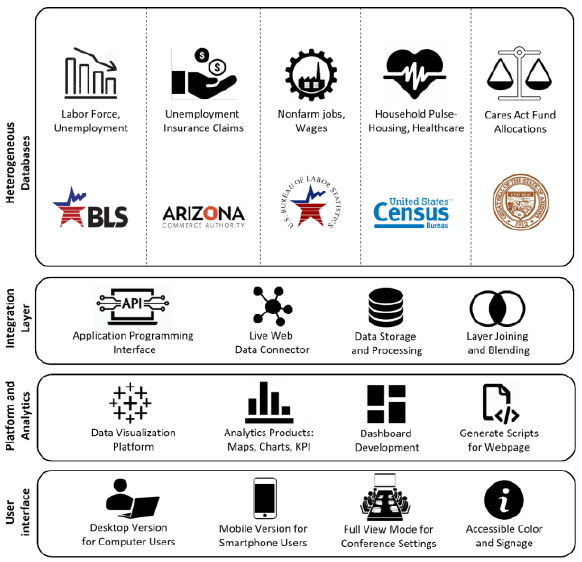
Figure 1. Technical architecture for Dashboard